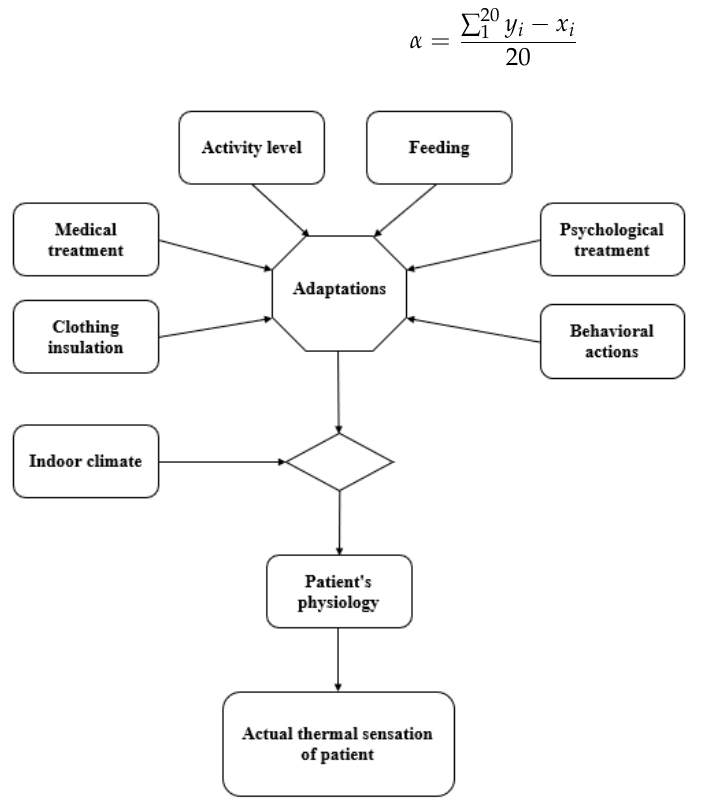
Figure 16. Flowchart of the holistic principle of the adaptive model. Table 7. Summary of the adaptive